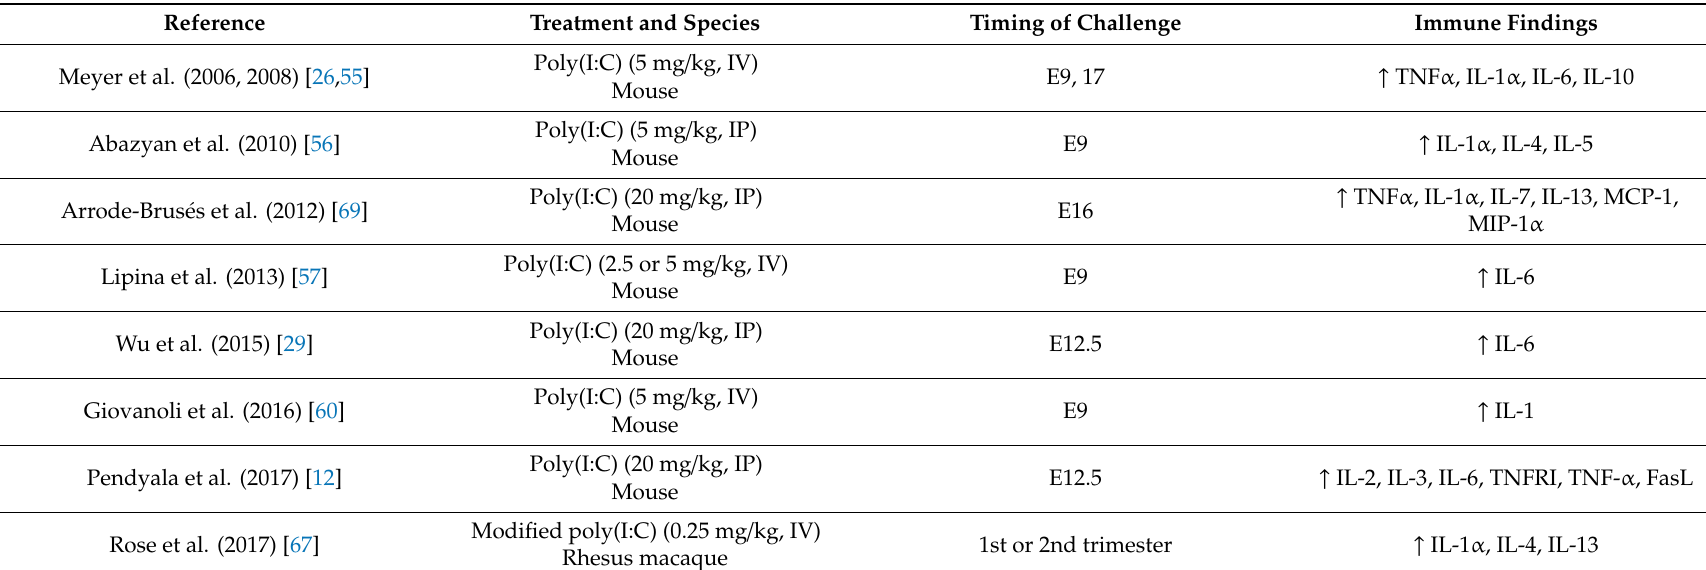
Table 3. MIA-induced cytokine increases in the fetal brain of animal